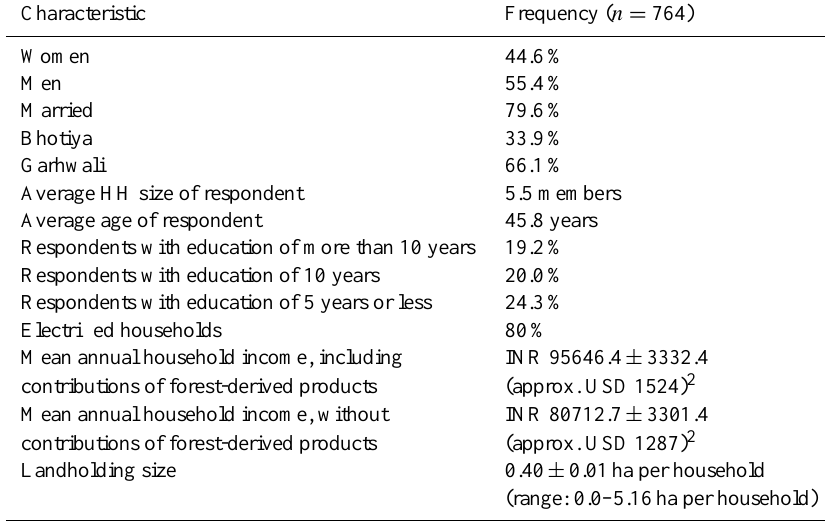
Table 2. Socio-economic profile of NDBR households. 1